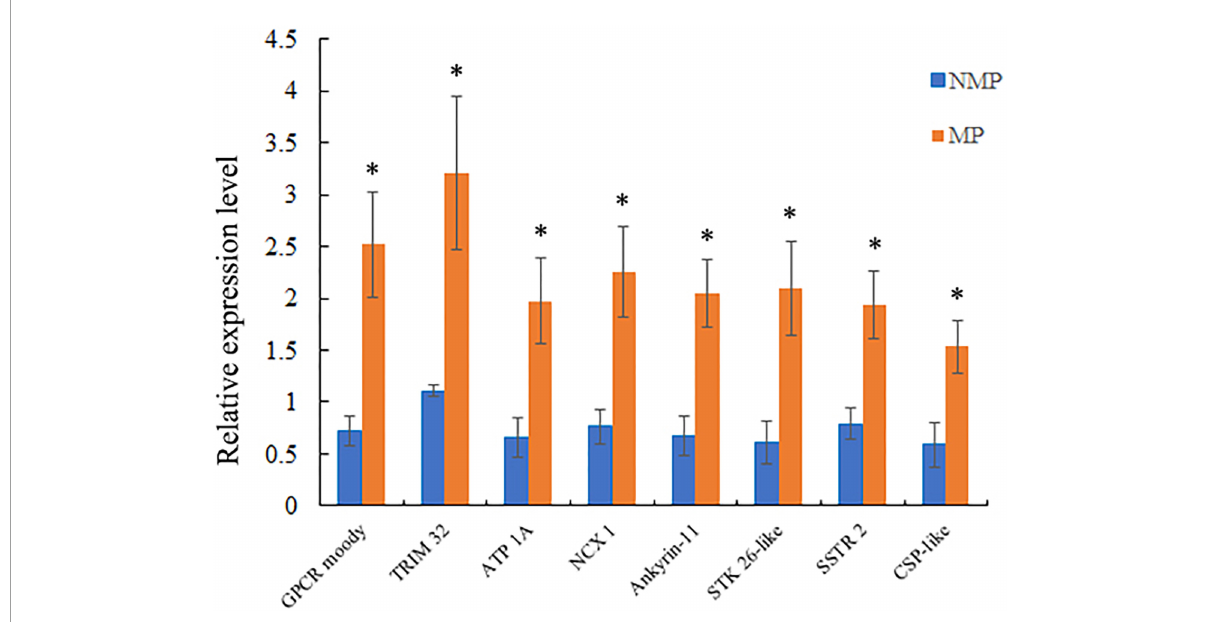
FIGURE4 Relative levels of selected differentially expressed unigene (DEG) expression by RT-qPCR. Levels were measured using the 2 − (cid:49)(cid:49) CT method; β -actin was the internal normalization control. Data were shown as mean ± SD, n = 3; ∗ P <